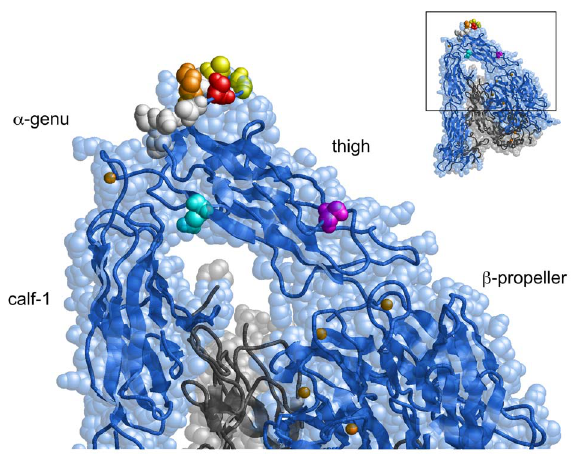
Figure 4. Locations of the critical residues for mAb binding in the three-dimensional a V b 3 structure. The crystal structure of the a V chain is shown by the blue spacefill representation, with its backbone shown by the ribbon. The b 3 chain is shown by the gray ribbon. The epitope residues Ser-462 and Ser-528 are highlighted in red and magenta, respectively. Gly-465 and Ala-467 — which create a binding interface for AMF-7, M9, and P2W7 — are highlighted in yellow. Lys-469, important for P2W7 binding, is highlighted in orange. Residues that did not affect mAb binding when mutated are highlighted in white (see text). Gln-589 is highlighted in cyan. Note that Ser-462 is located above the a -genu, while Ser-528 is located on the side of the thigh domain distal to the a -genu.